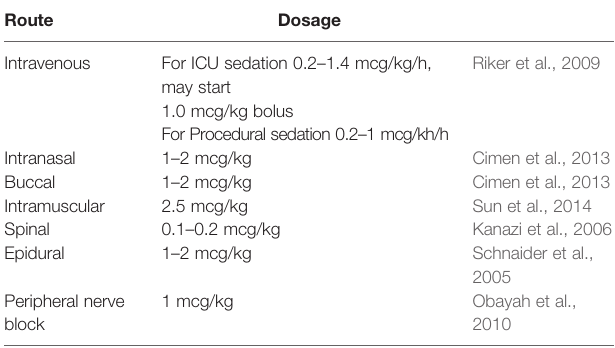
TABLE 2 | Dosage of DEX used in several administration routes.